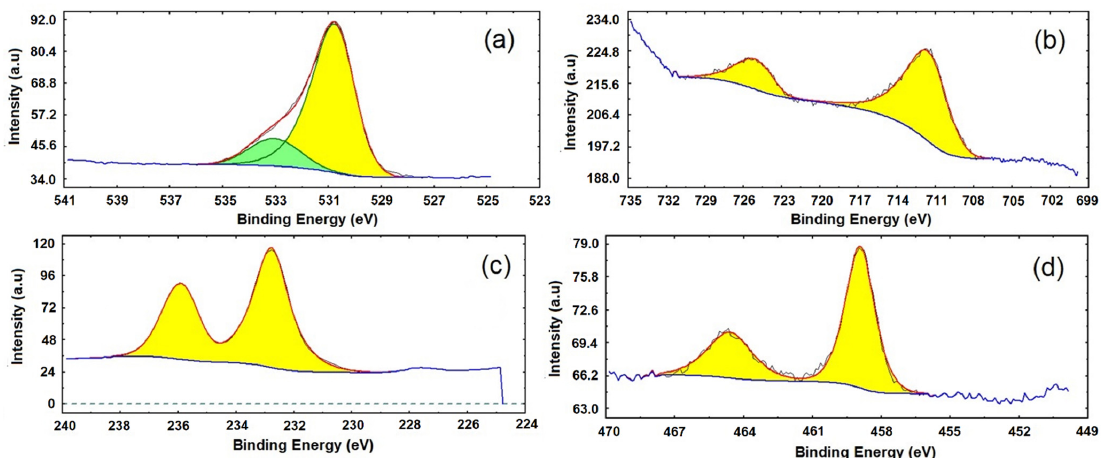
Figure 3. Individual XPS spectra of oxygen ( a ), iron ( b ), molybdenum ( c ), and titanium ( d ) in the coating on a steel substrate.